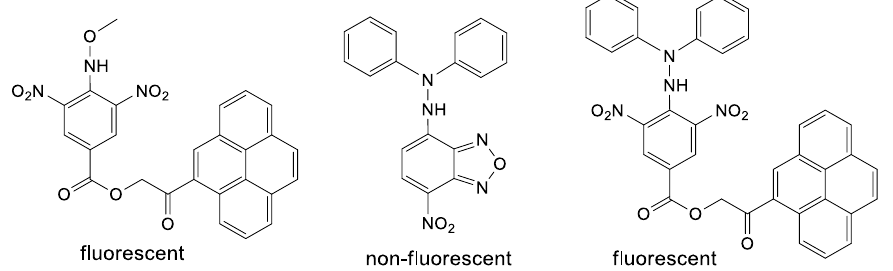
Figure 2. Methoxyamine and hydrazine derivatives, precursors of persistent free radicals, containing a pyrene or NBD fluorophore.